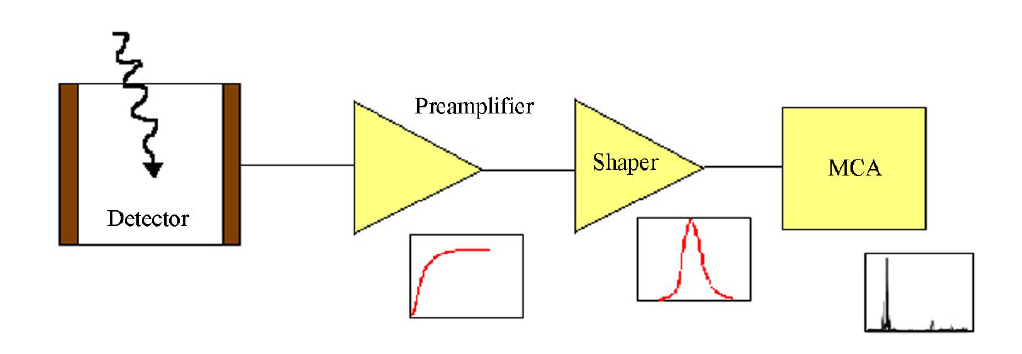
Figure 4. Block diagram of a typical spectroscopy